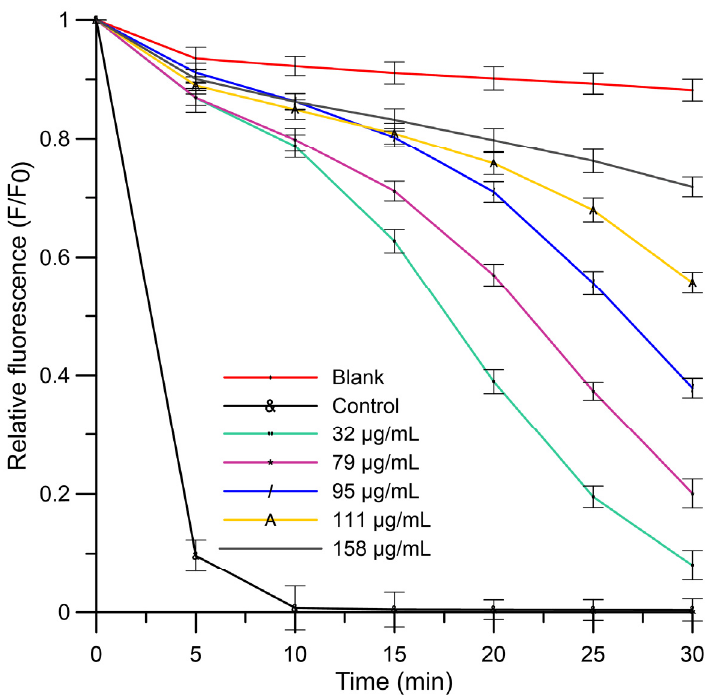
Figure 7. Relative fluorescence intensity of DPH-PA probe as a function of oxidation time of liposomes for AAPH radicals in the presence of PC concentrate at 32, 79, 95, 111 and 158 µ g/mL concentrations. The relative change in fluorescence intensity F/F 0 is a measure of the degree of lipid peroxidation (F 0 , fluorescence intensity in control sample; F, fluorescence intensity of samples in the presence of PC concentrate).